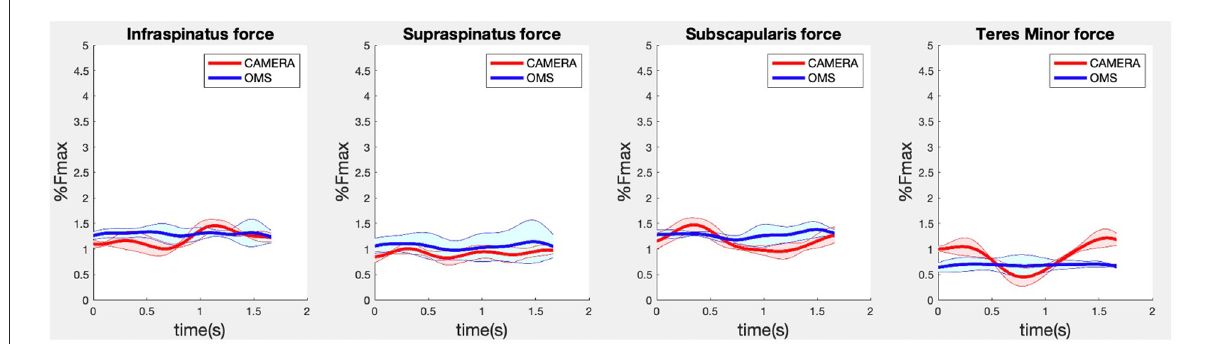
FIGURE8 Results for the rotator cuff muscle forces during the biceps curl exercise. Results obtained from OMS (blue) and camera (red) are presented as mean ± 1SD (shaded) over all participants.